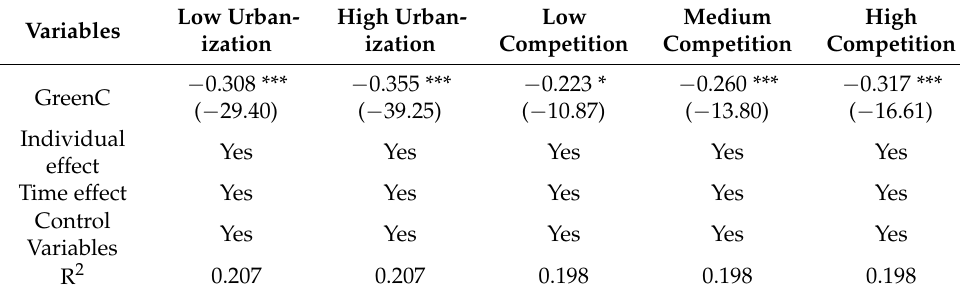
Table 9. Regression results for threshold heterogeneity.